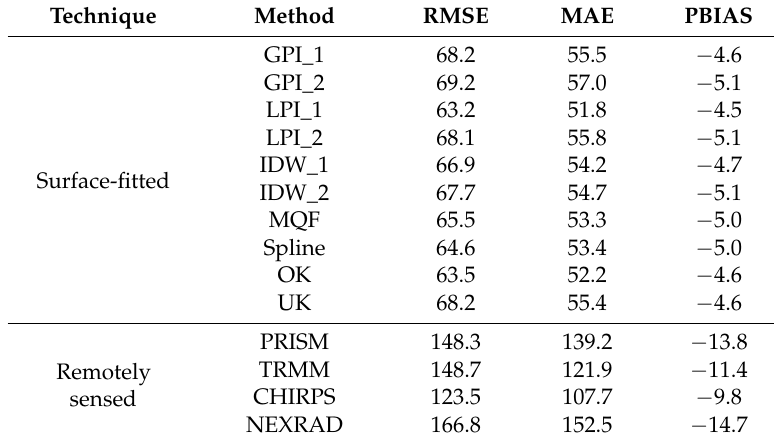
Table 6. Validation results showing the error associated with surface-fitted and remotely sensed annual total precipitation in the Hinkson Creek Watershed, Missouri,